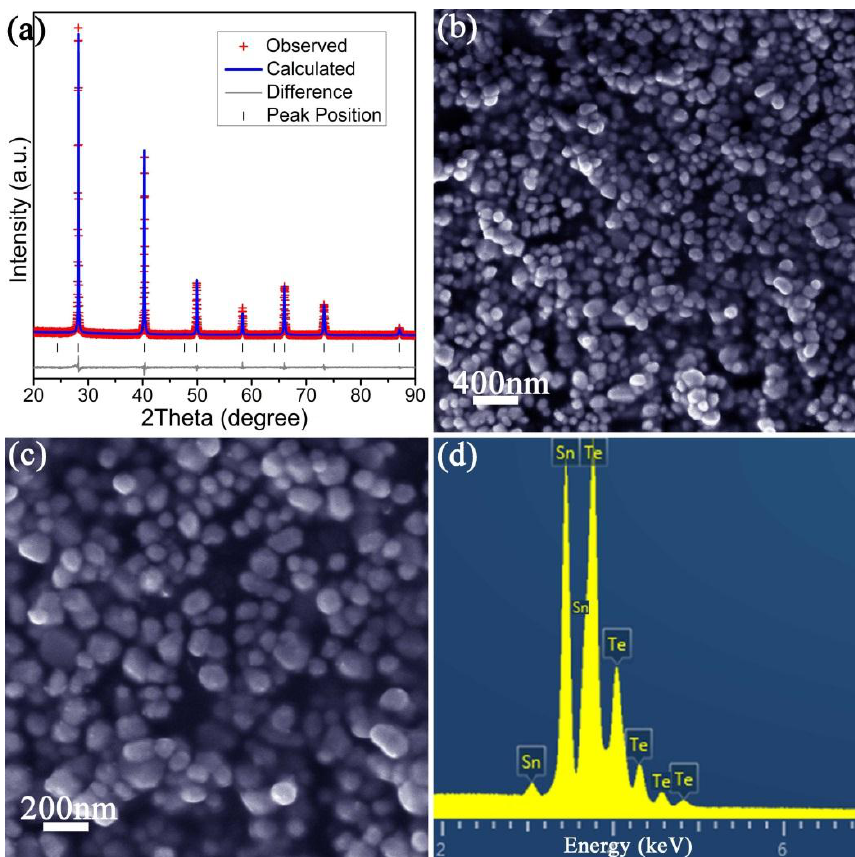
Figure 1. Characterisation of SnTe nanoparticles synthesised after 2 h: ( a ) Profile plot from Rietveld refinement against PXD data; ( b , c ) SEM images; ( d ) EDS spectrum. Table 1. Crystallographic data for SnTe nanoparticles synthesised after 2 h boiling.